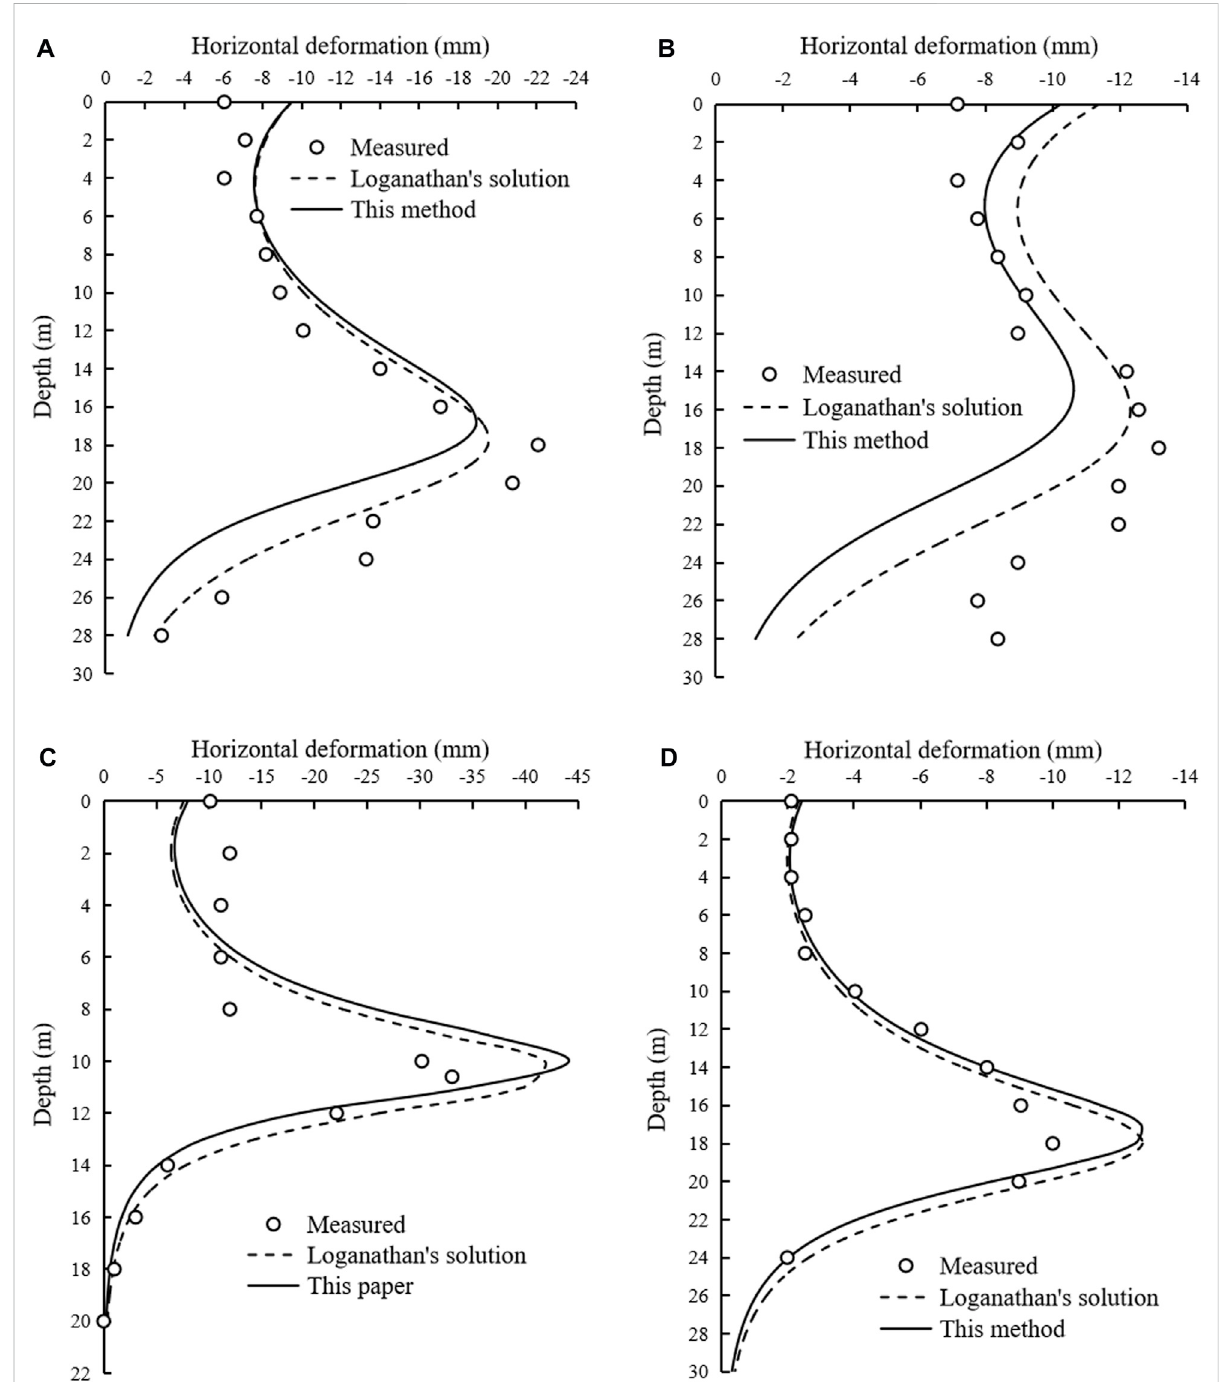
FIGURE 8 Horizontal deformation induced by general circular tunneling: (A) Heathrow Express Trail Tunnel: x = 6 m; (B) Heathrow Express Trail Tunnel: x = 9 m; (C) Thunder Bay Tunnel: x = 2.2 m; (D) Sewer Tunnel, Bangkok: x = 4 m.